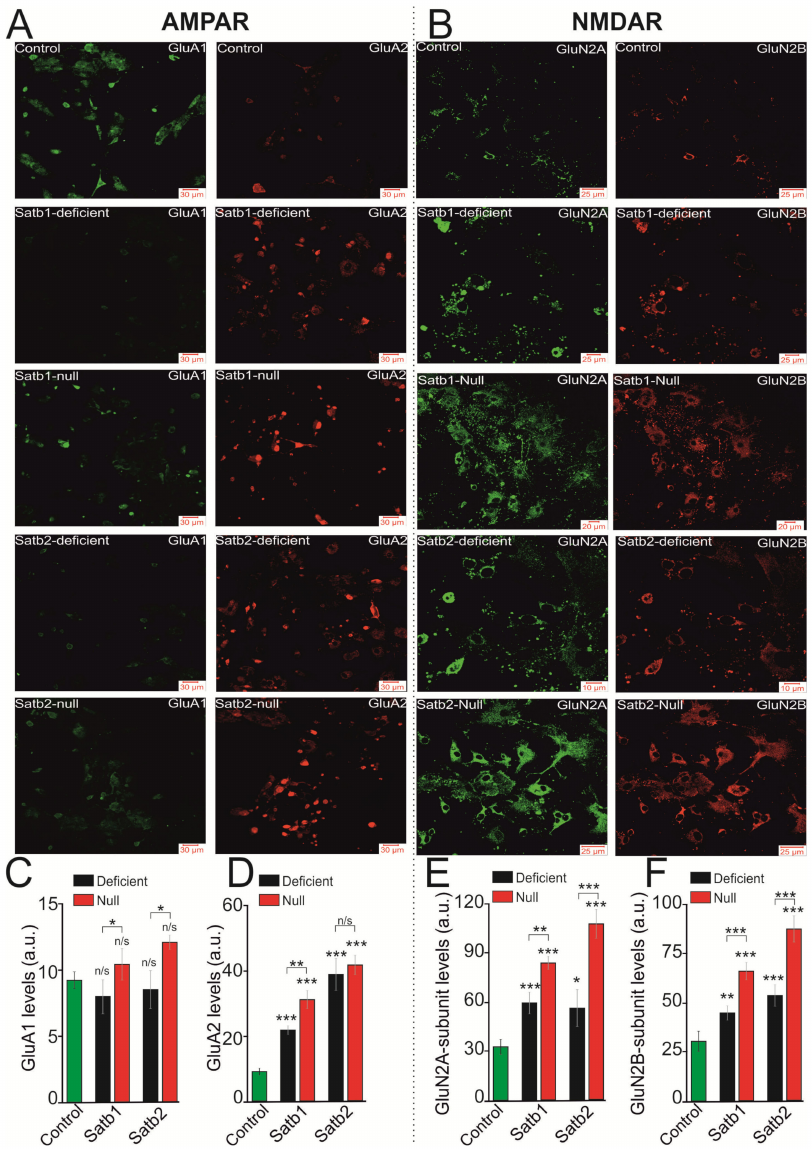
Figure 3. Expression of subunits forming AMPAR (GluA1, GluA2) and NMDAR (GluN2A, GluN2B) in neurons of the cerebral cortex derived from Satb-deficient, Satb-null, and control mice. ( A , B )—Immunostaining of GluA1 (green color), GluA2 (red color) subunits of AMPA receptors ( A ) and GluN2A (green color), GluN2B (red color) of NMDA receptors ( B ) of cortical neurons from control (Satb +/+ * Nex Cre/+ ), Satb-deficient (Satb fl/+ * Nex Cre/+ ) and Satb-null (Satb2 fl/fl * Nex Cre/+ ) mice. ( C – F) —The effects of Satb- and Satb2-deletions on the level of GluA1 ( C ), GluA2 ( D ), GluN2A ( E ), and GluN2B ( F ) subunits. Intensity levels of surface-expressed receptor subunits were determined by confocal imaging. We analyzed individual neurons which had fluorescence of Alexa Fluor 633 (GluA1, green color), Alexa Fluor 488 (GluA2, red color) and Alexa Fluor-555 (GluN2B, red color), and Alexa Fluor-594 (GluN2A, green color). The quantitative data reflecting the level of subunits expression are presented as fluorescence intensity values in summary bar charts (mean ± SEM). The values were averaged by 300 ± 50 neurons for each column. Statistical significance was assessed using paired t-test. The results obtained after immunostaining well agree with the data of fluorescent Ca 2+ measurements presented in Figures 4 and 5. After Ca 2+ measurements, the cells were fixed and stained by the antibodies. We used the scans from three independent view fields for each experimental group. n/s—data not significant ( p > 0.05); * p < 0.05; ** p < 0.01; and *** p < 0.001, comparing Satb-deficient group and Satb-null group with control mice. Significance indicated by a horizontal bar—comparison of Satb-deficient with Satb-null